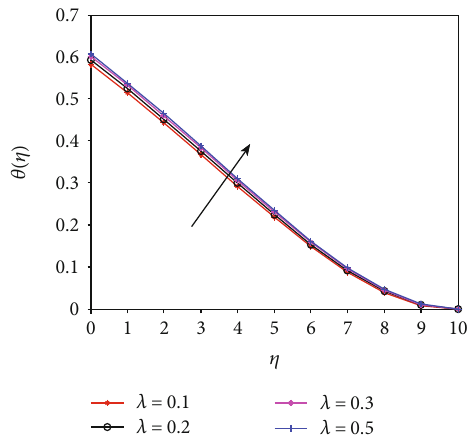
Bi = 0.1 Bi = 0.5 Figure 9: Temperature pro fi les for various values of Bi once Pr = 0 : 72 , λ = M = Gr = Ra = 0 : 1 .